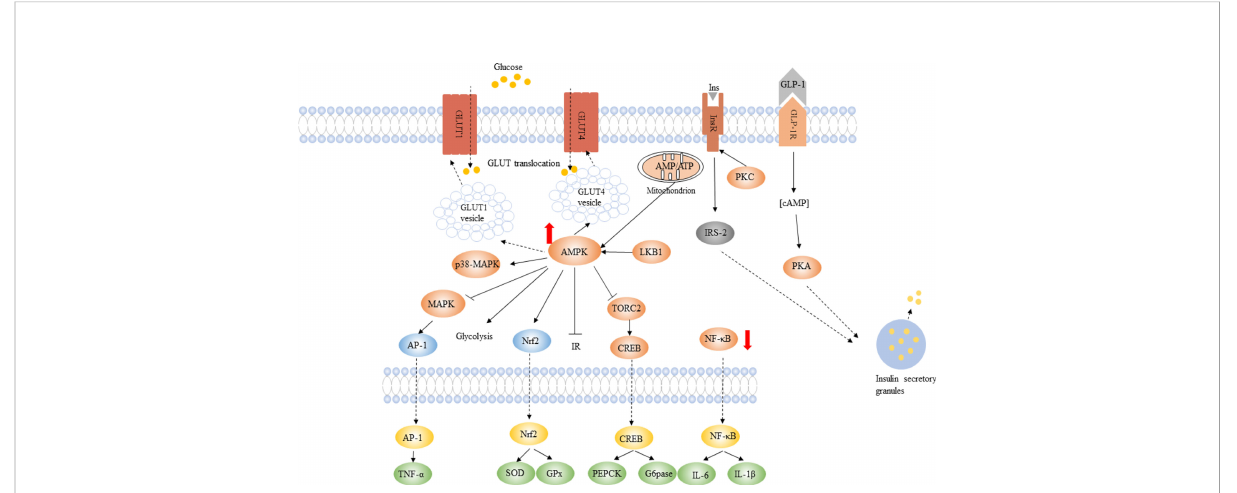
FIGURE 2 The potential mechanisms of berberine in regulating glucose metabolism, improving antioxidative and immune status. Berberine can enhance insulin sensitivity and improve insulin secretion. BBR induces glycolysis via activating AMPK pathway and increasing GLUT1 and GLUT4 translocation. BBR reduces the expression of PEPCK and G6Pase genes to suppress gluconeogenesis. BBR decreases the production of pro- in fl ammatory cytokines, for example, TNF- a . Up arrows indicate an increase or activation, and down arrows indicate a decrease or suppression. Modi fi ed from Xu et al. (2021) and Zhou et al.